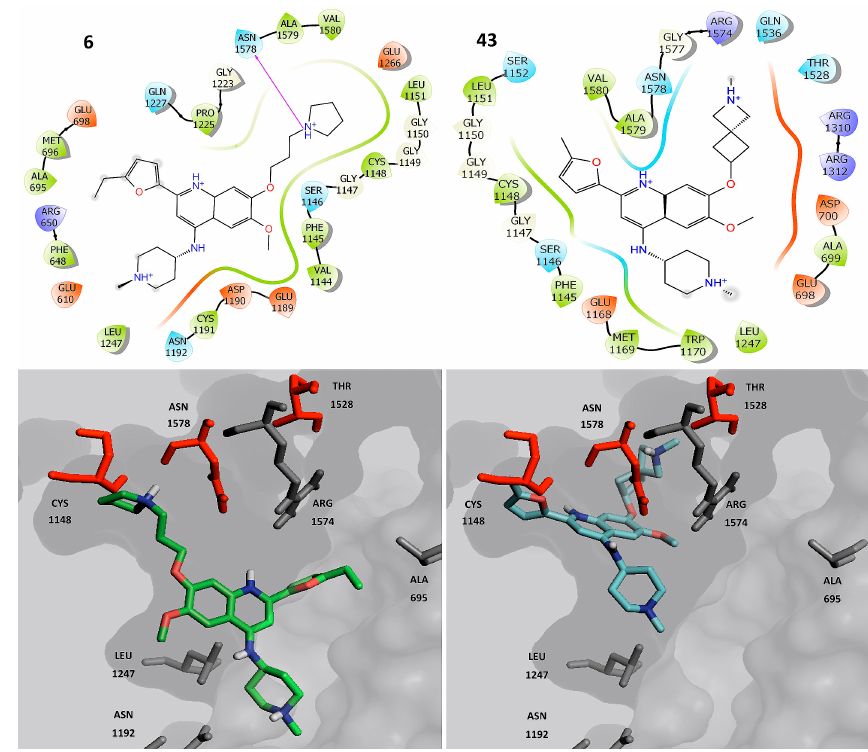
Figure 9. Predicted binding poses of selective compounds against DNMT1. Key amino acids proposed for the selective activity are highlighted in red.